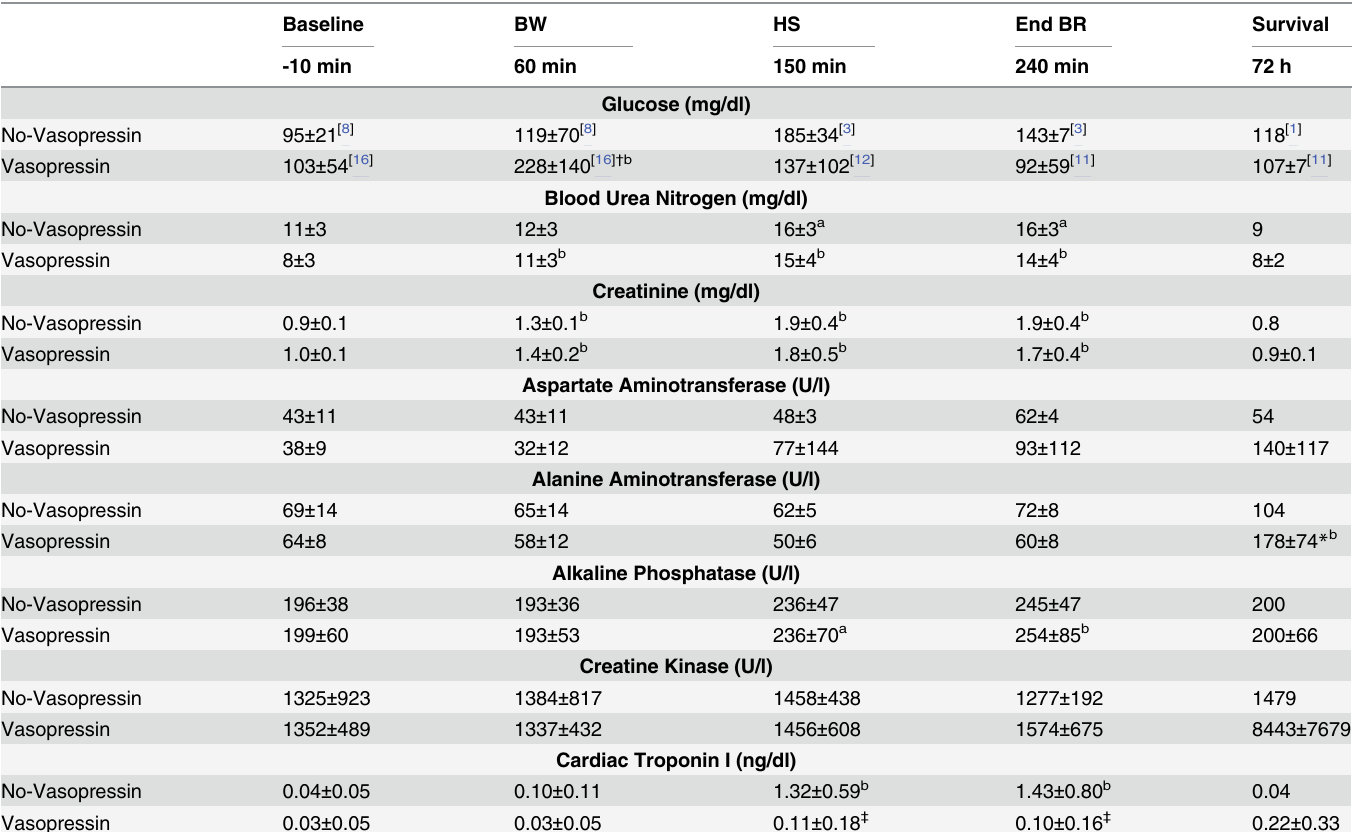
Table 1. Effect of vasopressin on indices of organ